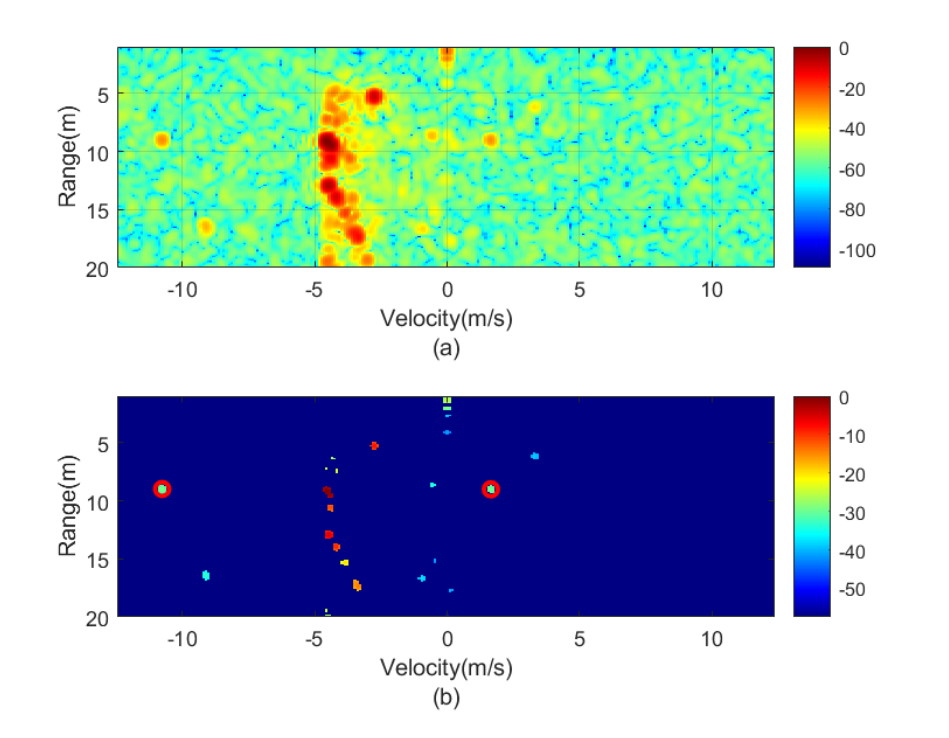
Figure 13. Measured range—Doppler map ( a ) and detection after CFAR processor ( b ) for the transponder modulated at 1000 Hz for a distance of about 10